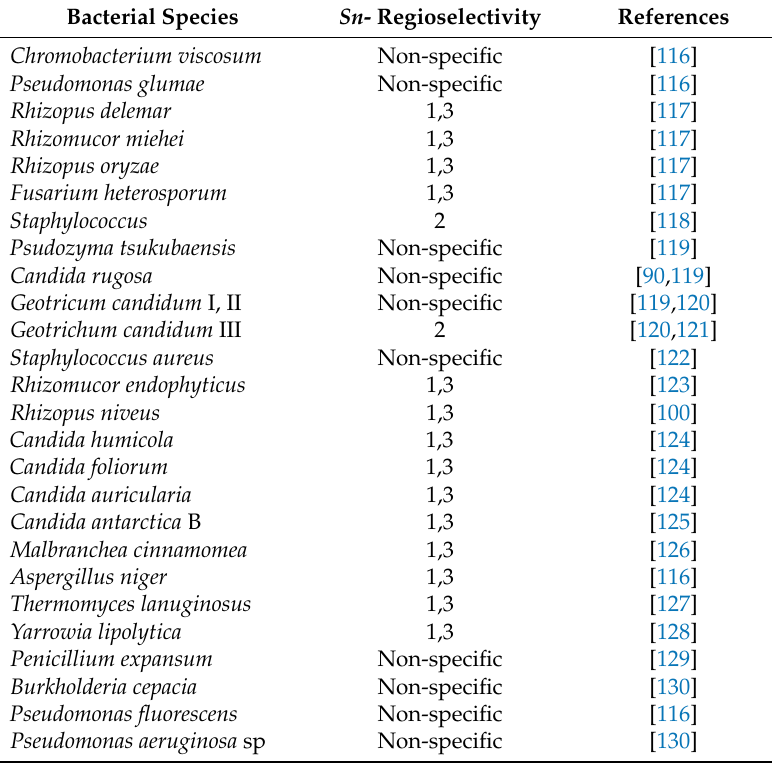
Table 2. Classification of microbial lipase according to their sn regioselectivity. Bacterial